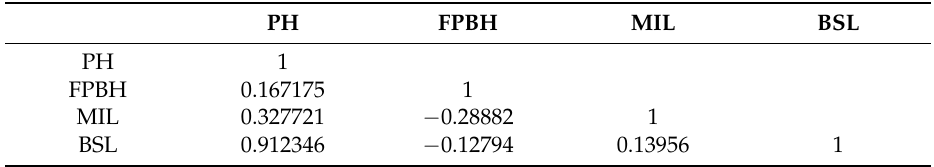
Table 3. Summary of the sequencing data for each sample.